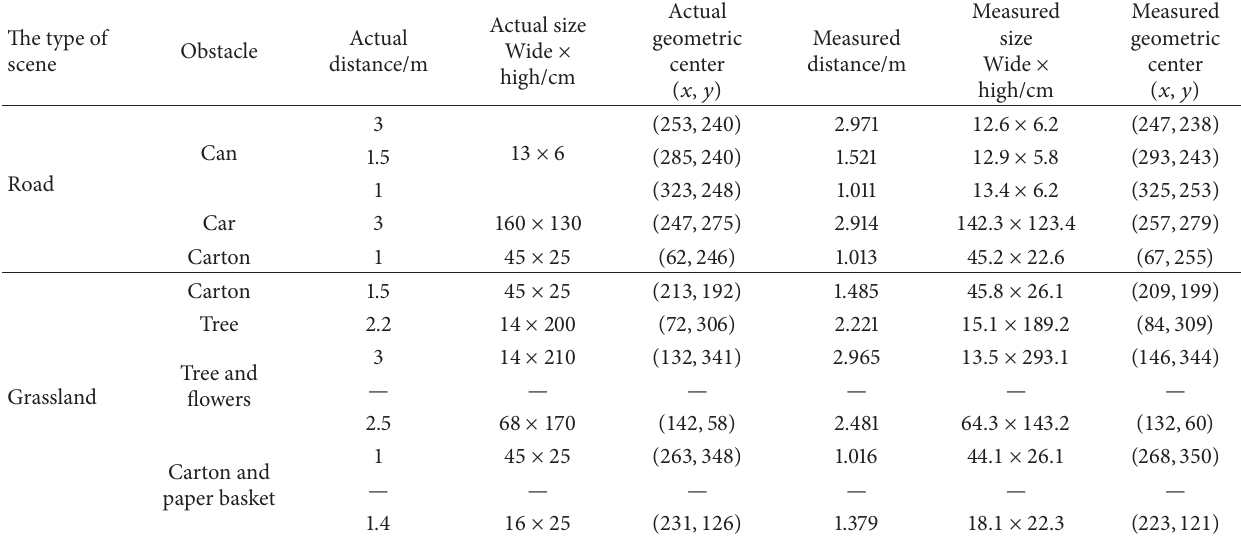
Table 2: Experimental parameters and